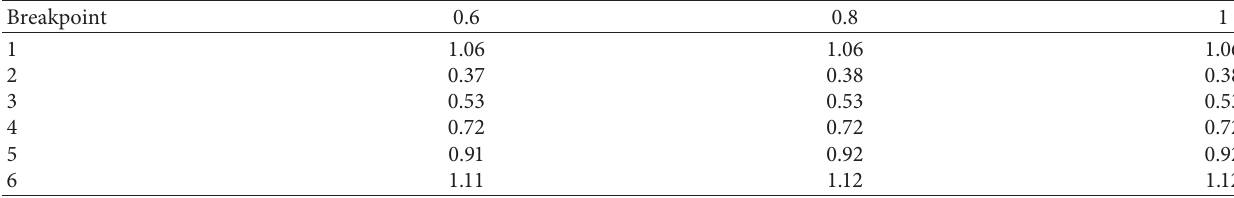
Table 11: The value of dev p for each breakpoint for the first sample problem.